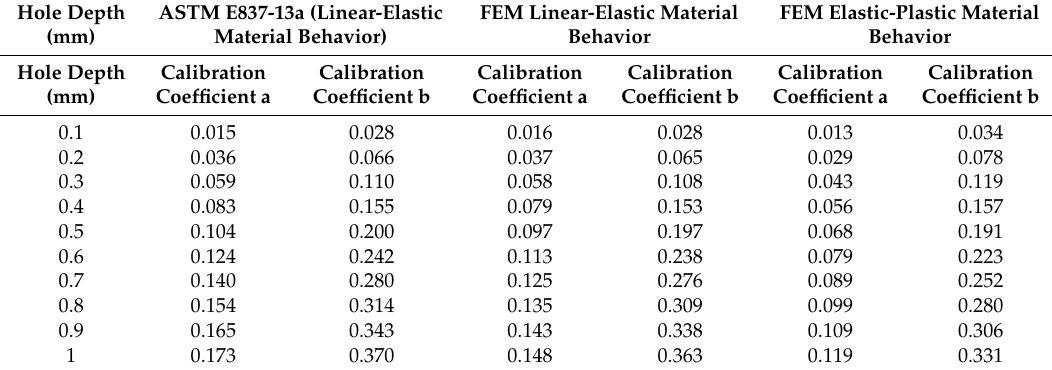
Table 3. Calibration